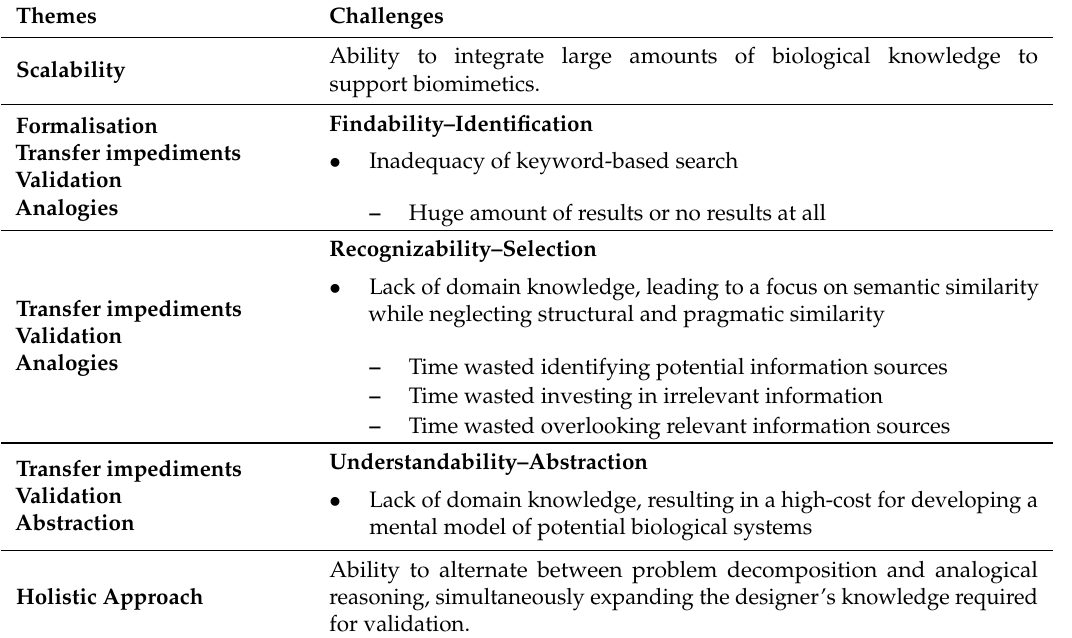
Table 2. Overview of the challenges Computer-Aided Biomimetics tools should overcome and the related themes of common mistakes and recurring findings. Adapted from Kruiper et al. [9], and Vattam and Goel